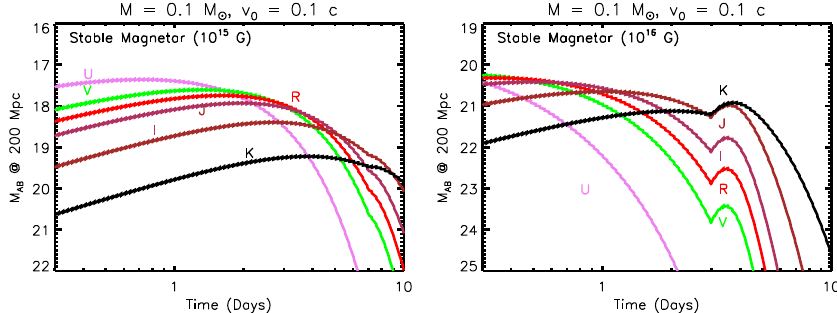
Fig. 11 Same as Fig. 10, but calculated for ejecta opacities corresponding to lanthanide-free